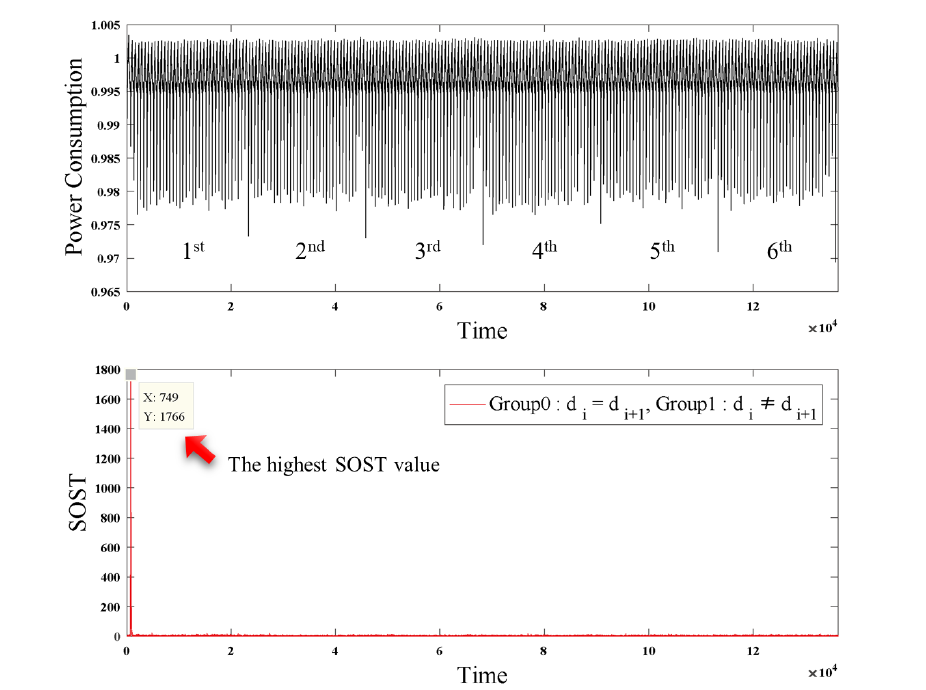
Figure 9. Hardware implementation: one of the subtraces ( top ) and the SOST value between two subgroups ( bottom